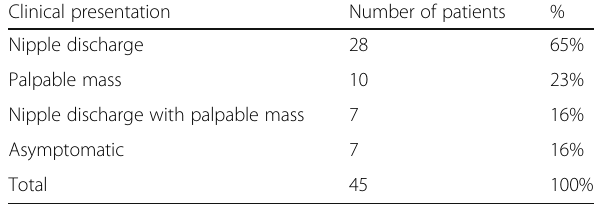
Table 1 represented the clinical presentation of our patients Clinical